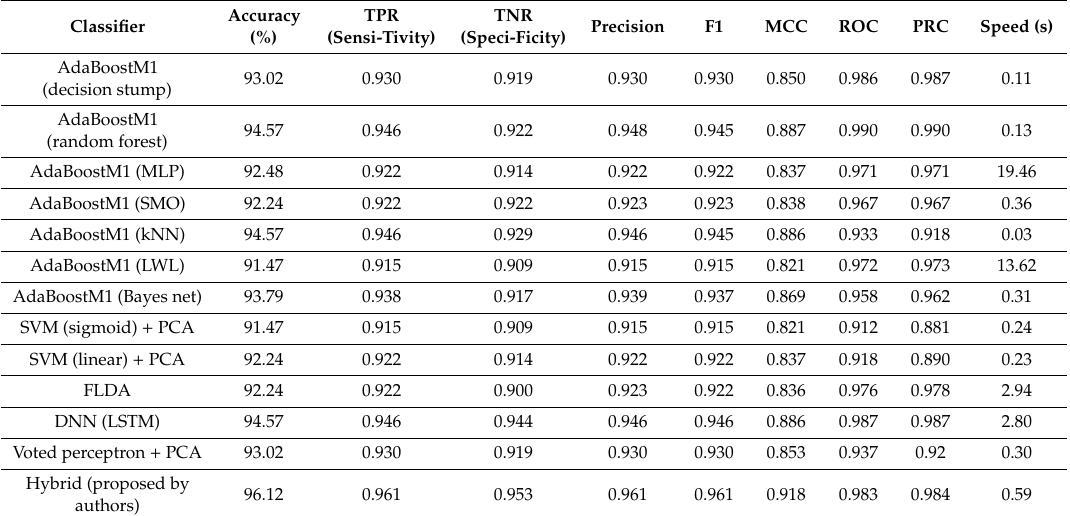
Table 3. Healthy vs. sick classification results for all features (accuracy metrics and speed, 10-fold classification): best values are shown in boldface.